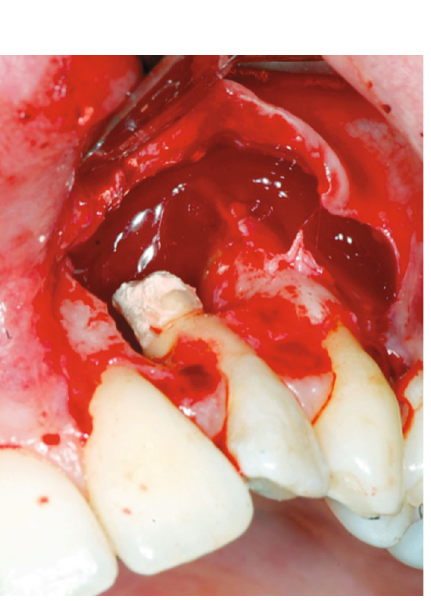
Figure 5: Endodontic surgery.